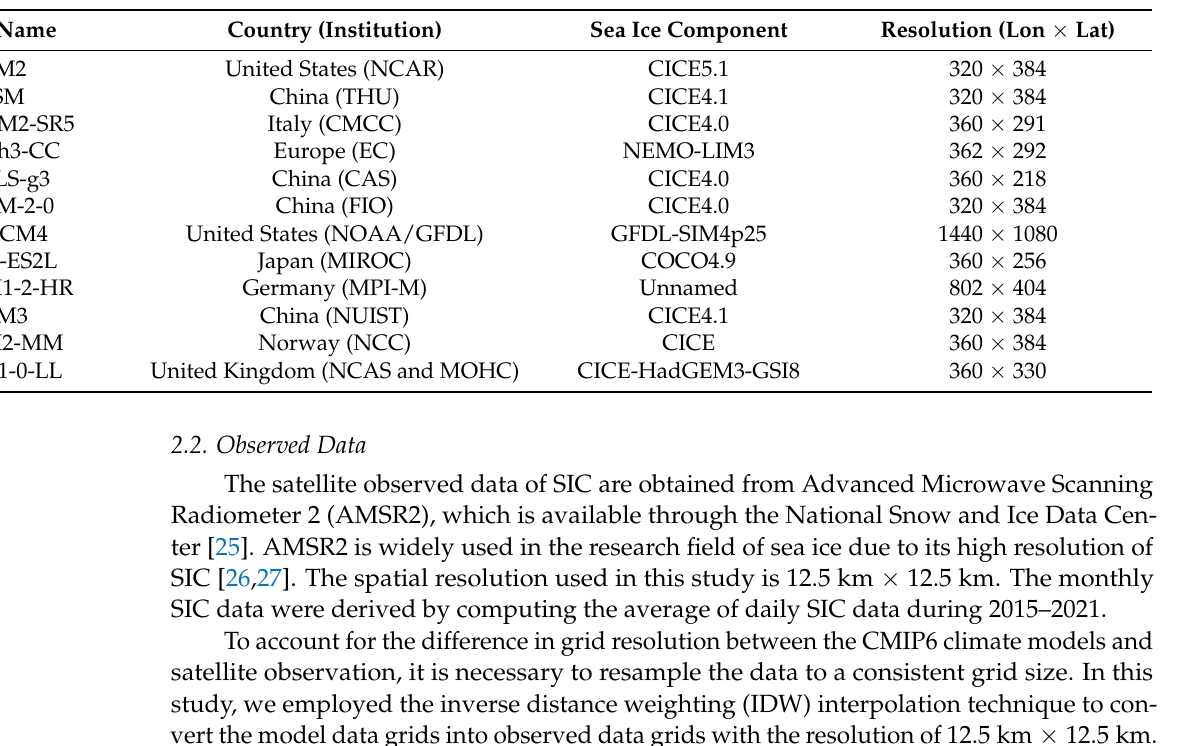
Table 1. The information of CMIP6 models used.